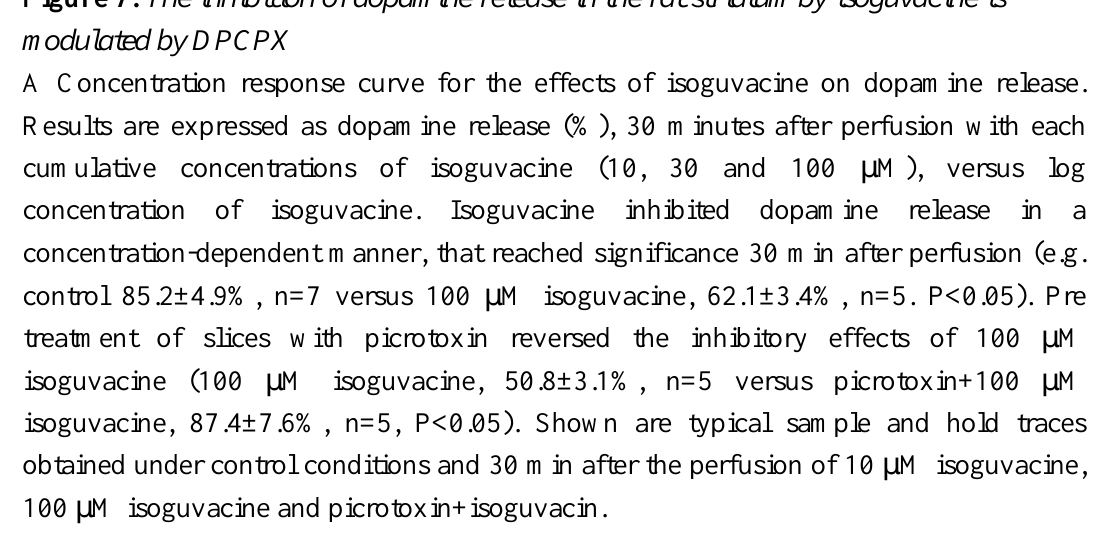
Figure 7. The inhibition of dopamine release in the rat striatum by isoguvacine is modulated by